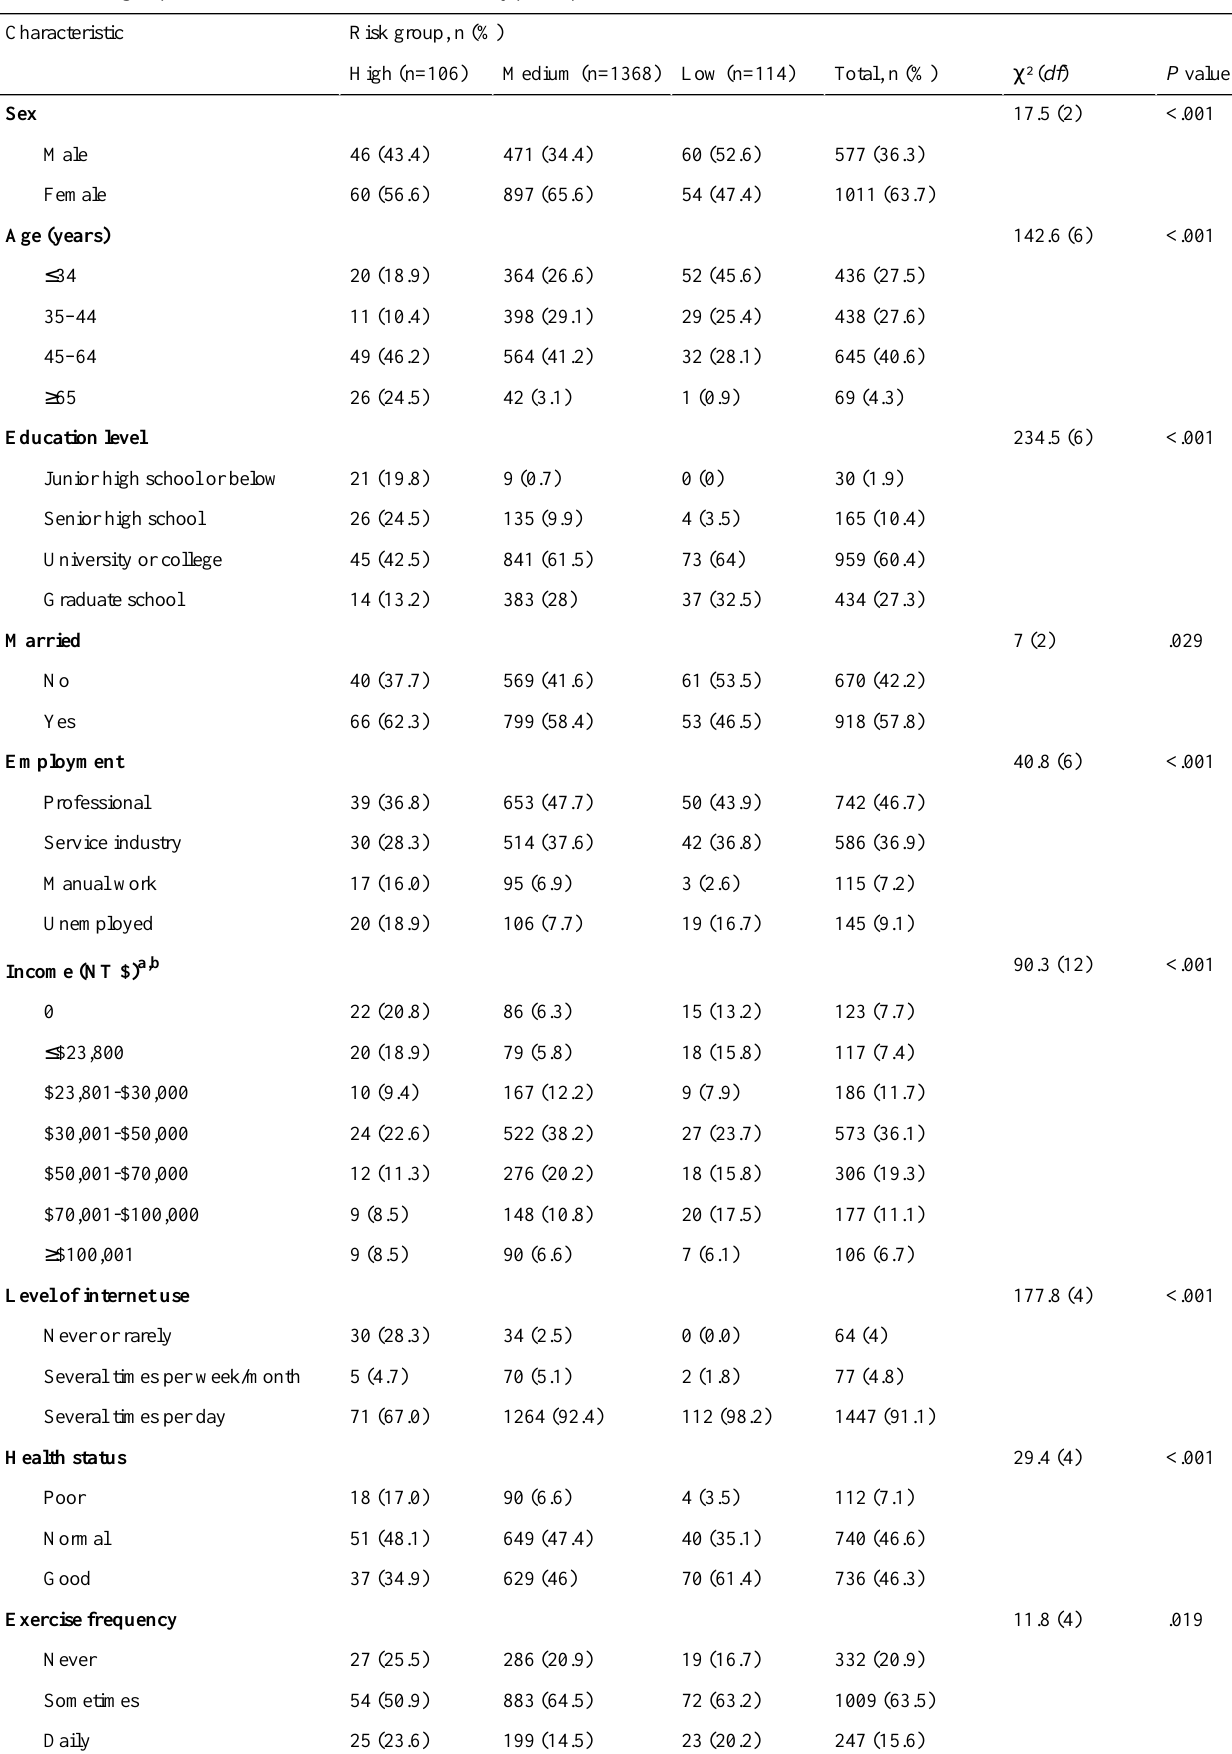
Table 5. Risk groups and characteristic distribution of study participants. Risk group, n